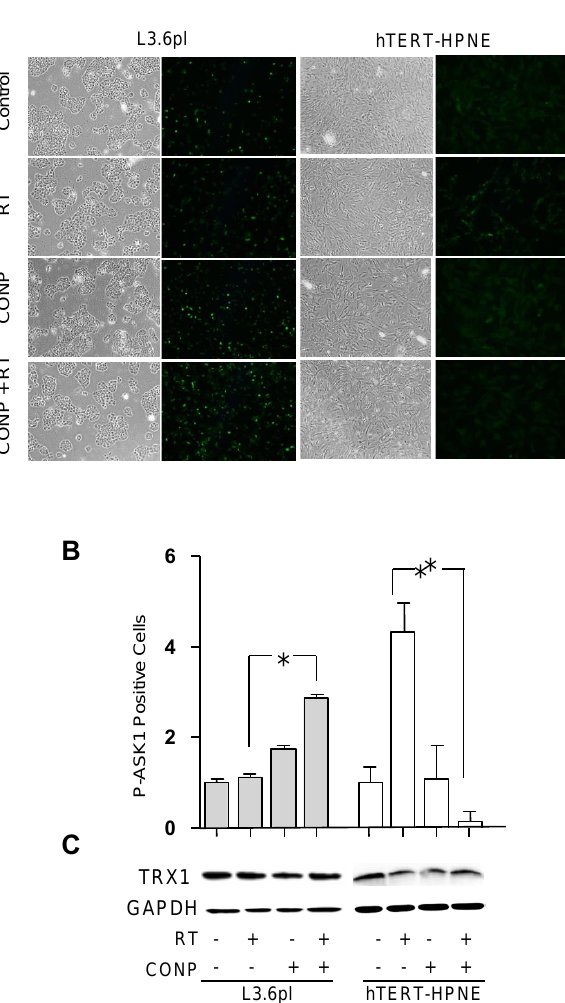
Figure 4. CONP Sensitization Increases RT-Induced ASK1 Activation Selectively in Pancreatic Cancer Cells. ( A ) The L3.6pl and hTERT-HPNE cells were pre-treated with 0 μM or 10 μM CONPs for 24 hours followed by exposure to 0 Gy or 5 Gy RT. After 4 hours, the cells were fixed, stained for p-ASK1 and analyzed. Representative phase contrast and fluorescent microscopic images are shown. ( B ) The number of fluorescent cells in 10 fields of view per condition was counted and normalized to untreated control group. ( C ) Unaltered TRX1 levels in an aliquot of the cells were determined by western blot. * p < 0.001; ** p < 0.0001.